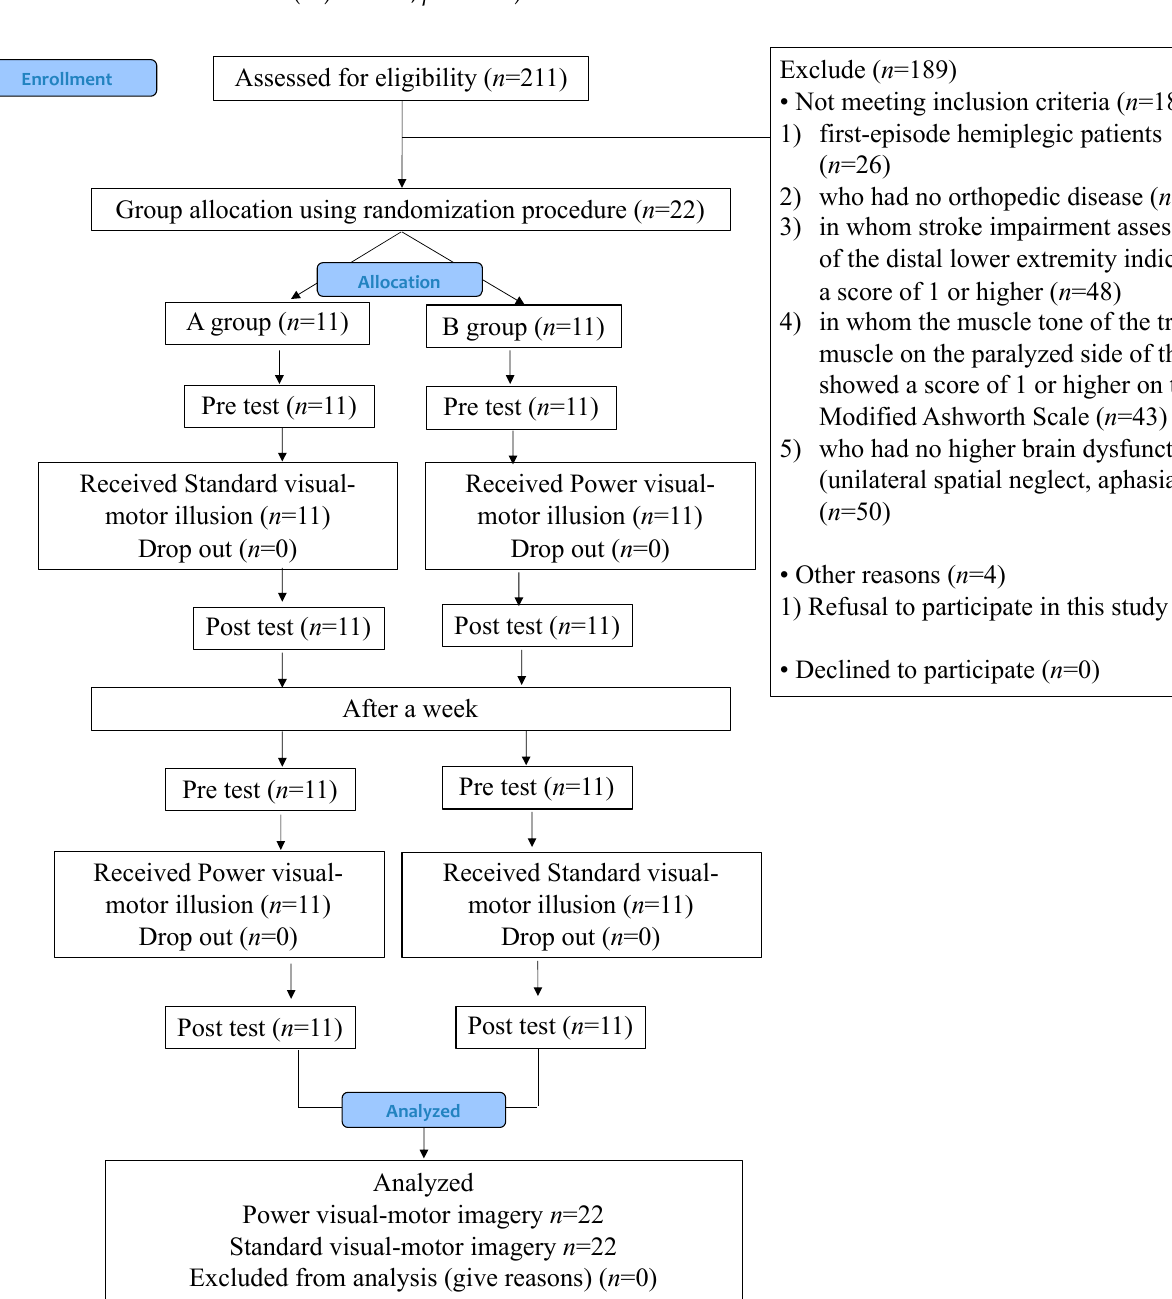
Figure 2. Flow diagram used for the selection of participants for this study.